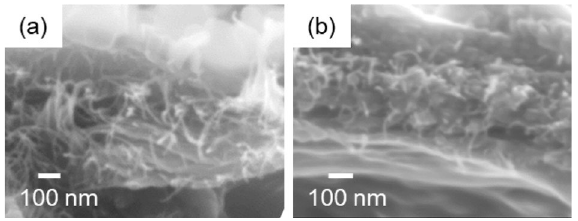
Figure 6. Cross-sectional SEM images of the surface layer of leaf blades before ( a ) and after ( b ) silica accumulation. We observed the surface layers at the root ( a ) and the tip ( b ) of a leaf blade that was cultured for about 1 month on a cotton bed.